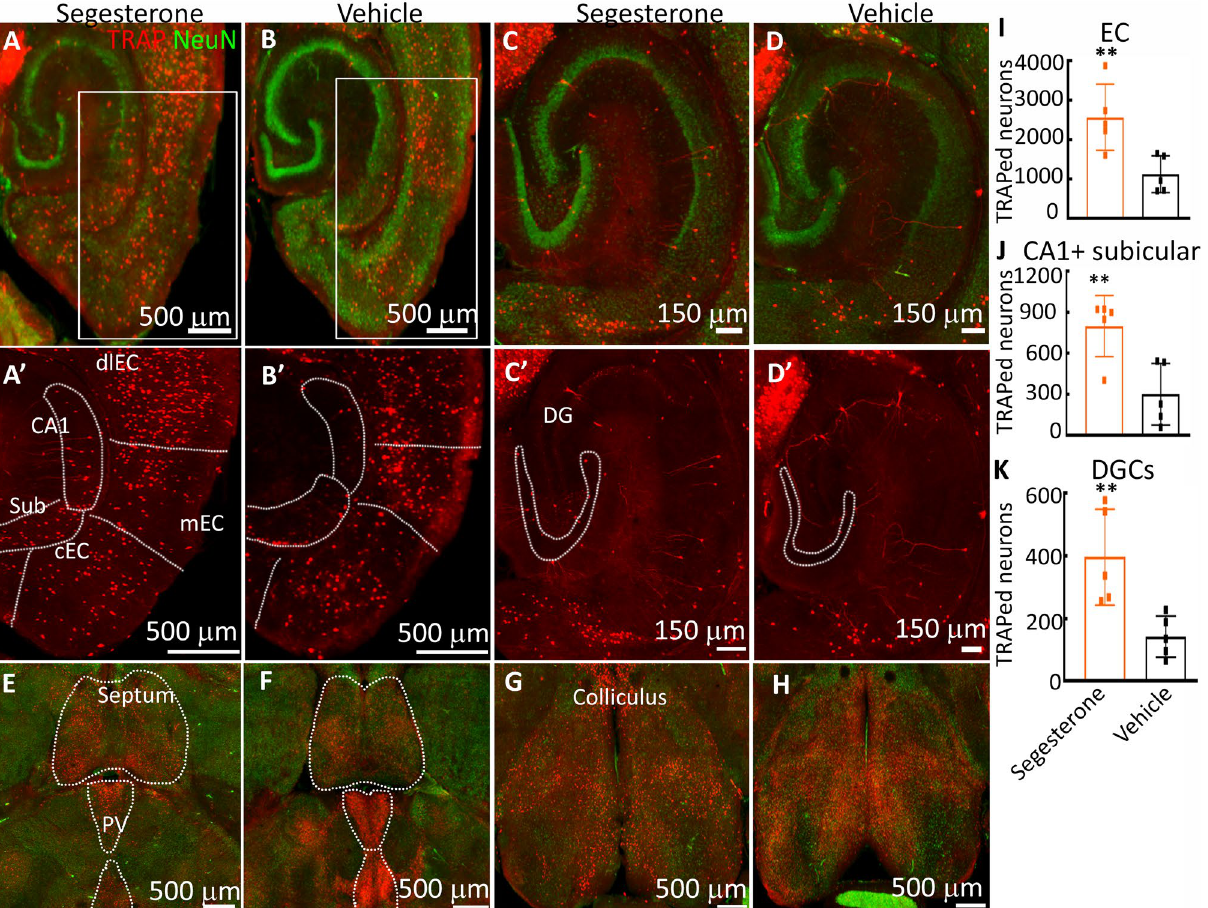
Figure 3. The effect of PR activation on the number of active neurons in the EC and hippocampus of adult male mice. ( A , B ) Representative images from segesterone- (10 mg/kg, subcutaneous) and vehicle- (20% β-hydroxycyclodextrin) treated male mice respectively. 4OHT was administered 2 days after the treatment in home cages to TRAP the active neurons (red). The green fluorescence corresponds to the expression of neuronal marker protein NeuN. ( A ′ , B ′ ) Magnified boxed areas from A and B respectively. The CA1, subiculum (sub), central (cEC), medial (mEC) and dorsolateral (dlEC) EC regions are marked. ( C , D ) Representative images from segesterone- and vehicle-treated mice show active DGCs, the NeuN immunoreactivity is shown in green. ( C ′ , D ′ ) Images showing the TRAPed DGCs in the segesterone- and vehicle-treated animals. ( E , G ) and ( F , H ) Images showing the TRAPed neurons in the septum, paraventricular thalamic nucleus, and colliculus of segesterone- and vehicle-treated animals respectively. ( I – K ) The number of TRAPed neurons in the entorhinal cortex, combined CA1 and subiculum, and DGCs in segesterone- and vehicle-treated animals, n = 5 each, ** p = 0.0098 for EC, p = 0.008 for CA1 and subiculum, and p = 0.0094 for DGCs, student’s